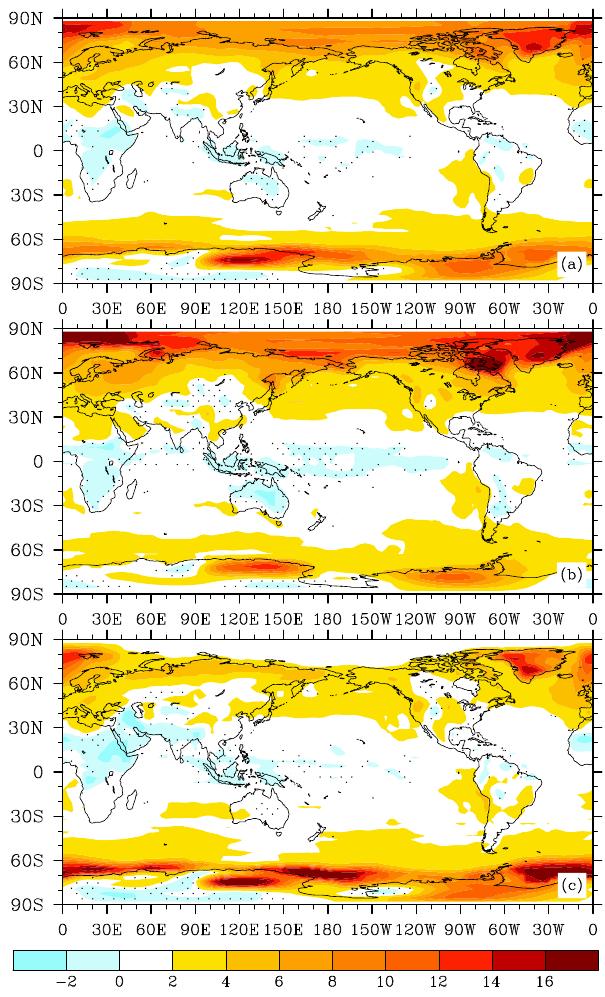
Fig. 3. Surface air temperature anomaly ( ◦ C) between the mid- Pliocene experiment and the pre-industrial experiment for the an- nual period (a) , winter (b) and summer (c) seasons. Areas with a confidence level less than 95% are